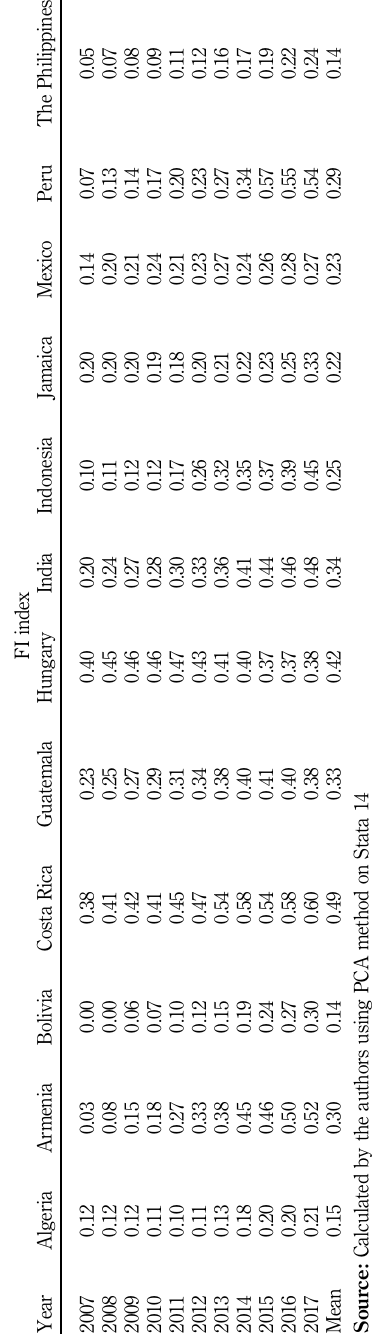
Table III. Estimation of the FI index of low FI level group in developing